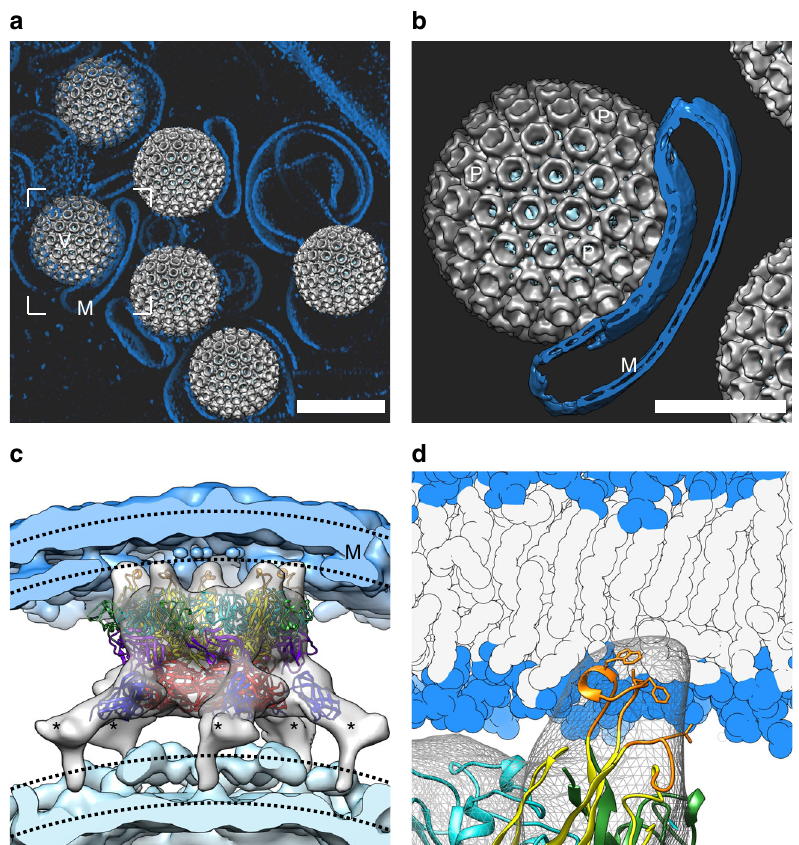
Fig. 3 Gc fusion loop unshielding and target membrane insertion. a A volumetric rendering is shown for tomographic reconstruction of puri fi ed RVFV virions and liposomes (M) incubated for ~30 s at pH 5.0. Surfaces of RVFV virions (V) were rendered by placing sub-tomogram averages of the virions back in the density. Scale bar, 100 nm. b A close-up of one virion sub-tomogram average with pentameric capsomers labelled (P) and showing a close interaction with the liposome membrane (M). The liposome membrane was rendered by placing sub-tomogram averages of liposome membrane back in the tomogram. Scale bar, 50 nm. c Sub-tomogram average of the pentamer at pH 5.0 with its apical densities embedded in the target liposome membrane (blue). Fitted X-ray structures of Gn and Gc are represented as ribbons and coloured as in Fig. 2. The fusion loop (FL) is in orange. Gn – Gc capsomers are rendered as a grey surface, viral membrane is in teal and liposome membranes are in light blue in a – c . The locations of the two lea fl ets in both the viral and the liposomal membrane are indicated with a dashed line. Unoccupied densities, assigned to C-terminal parts of the Gc and Gn glycoproteins that are absent from the fi tted crystal structures, are indicated with asterisks. d Close-up of the inserted fusion loop. The liposome membrane is shown as a cartoon with lipid head groups in blue and hydrophobic tails in grey. The sub-tomogram average is shown as a